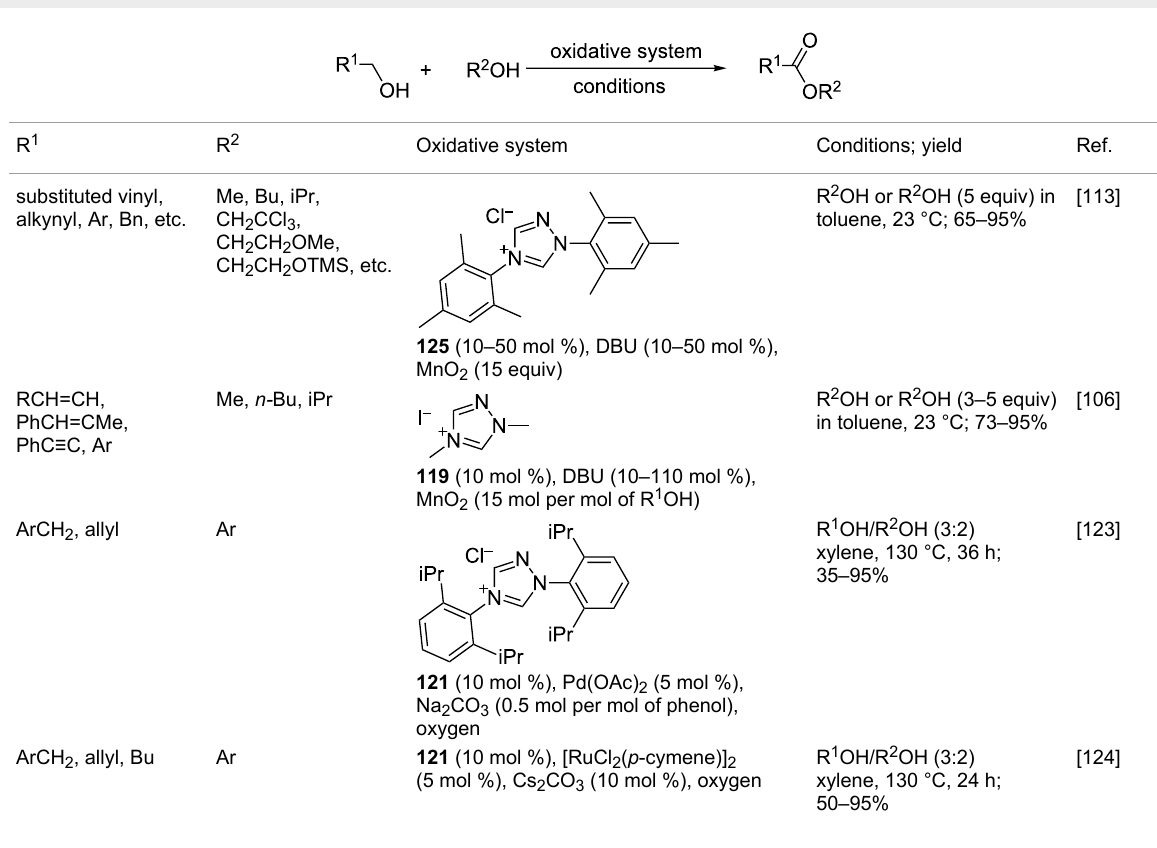
R 1 R 2 Oxidative system Conditions; yield